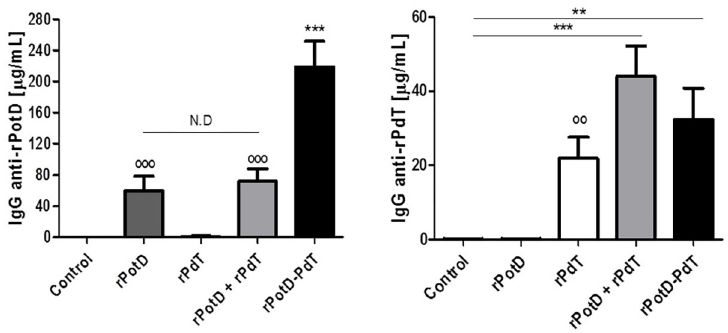
Fig 3. Antibody production induced by immunization. Sera were collected 14 days after the third immunization with rPotD, rPdt, rPotD + rPdT and rPotD-PdT, and individually tested against rPotD or rPdT. Serum from animals that received Aluminum hydroxide diluted in saline was used as control. Results are the mean ± SD of 5 mice. ��� p < 0.001 and �� p < 0.01, for multiple comparison by ANOVA and˚˚˚ p < 0.001 and˚˚ p < 0.01, for paired analysis between the immunized and control groups (t-test). N.D = Not